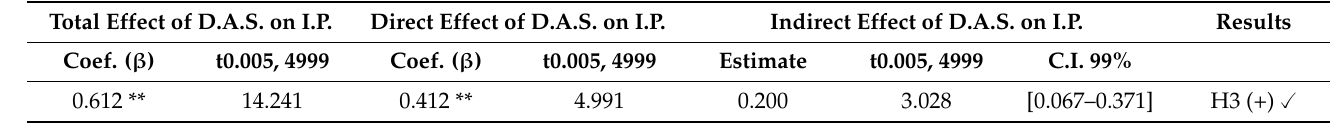
Table 7. Summary of indirect